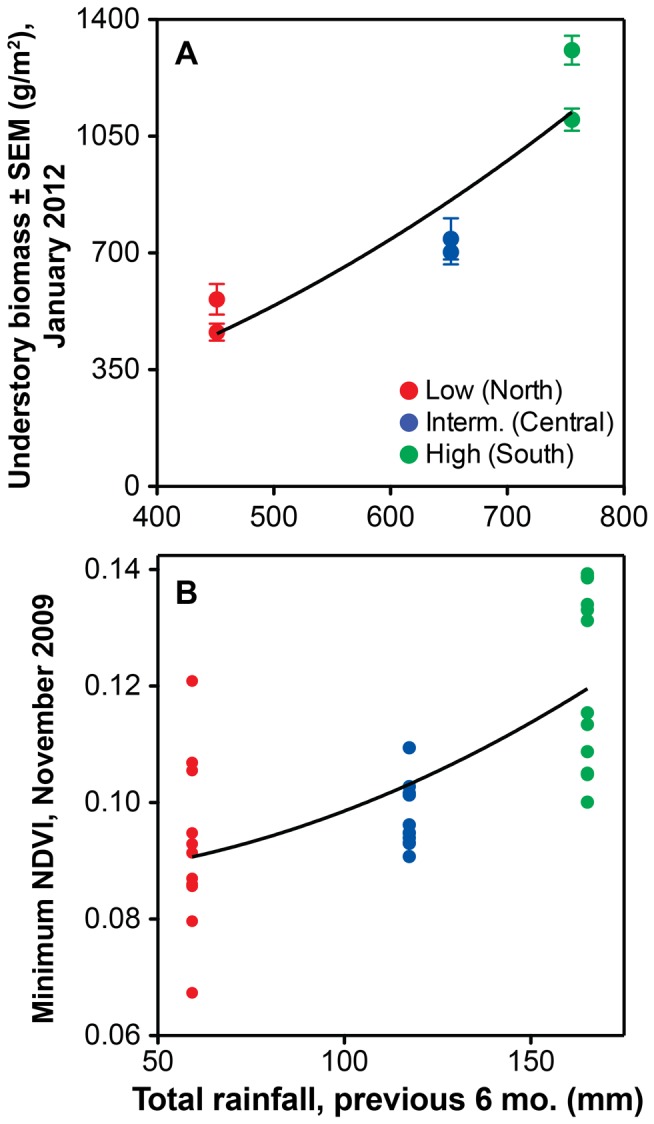
Relationship between two metrics of productivity and rainfall in the six months prior to productivity measurement.(A) Mean peak understory biomass (grasses and forbs) in two 64-m2 grids located within total-exclusion plots at each site. (B) Mean NDVI in each plot, calculated from Quickbird satellite imagery. Rainfall was squared in regression analyses to better fit the data.